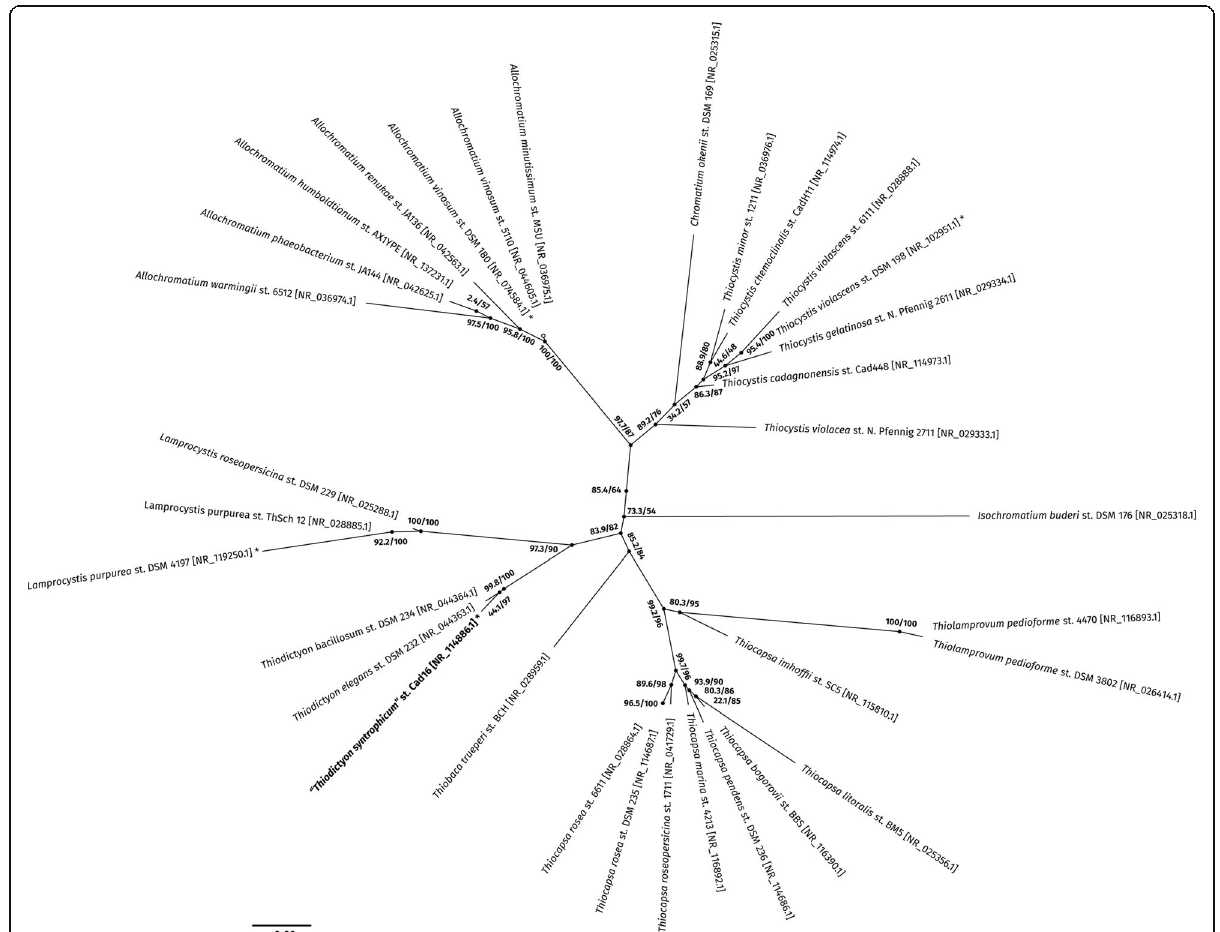
Fig. 2 Phylogenetic tree indicating the position of “ T. syntrophicum ” sp. nov. strain Cad16 T relative to other genomes sequenced within the family Chromatiaceae . The tree was inferred from 16S rRNA sequences ( ≥ 1300 bp) using the maximum likelihood algorithm of the IQ-TREE software [62]. 1000 bootstrap replicates were performed. Numbers at the nodes indicate the SH-aLRT support (%) and ultrafast bootstrap support (%), respectively. Asterisk mark strains with complete genome sequences available. Open circles as node shapes indicate bootstrap support